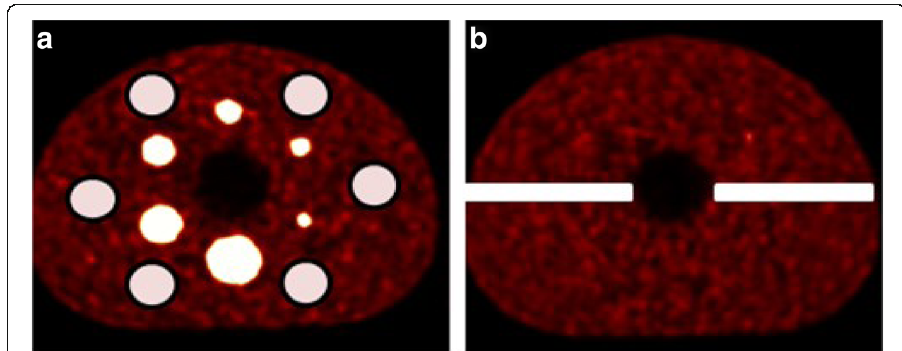
Fig. 2 The regions of interest used to a calculate the COV in the phantom background at slice 38 and b the intensity distributions of the standard deviation image at slices 53 – 57 (right). Both images are generated using the physical phantom data, but the regions of interest are equally extracted from the corresponding slices of the simulated